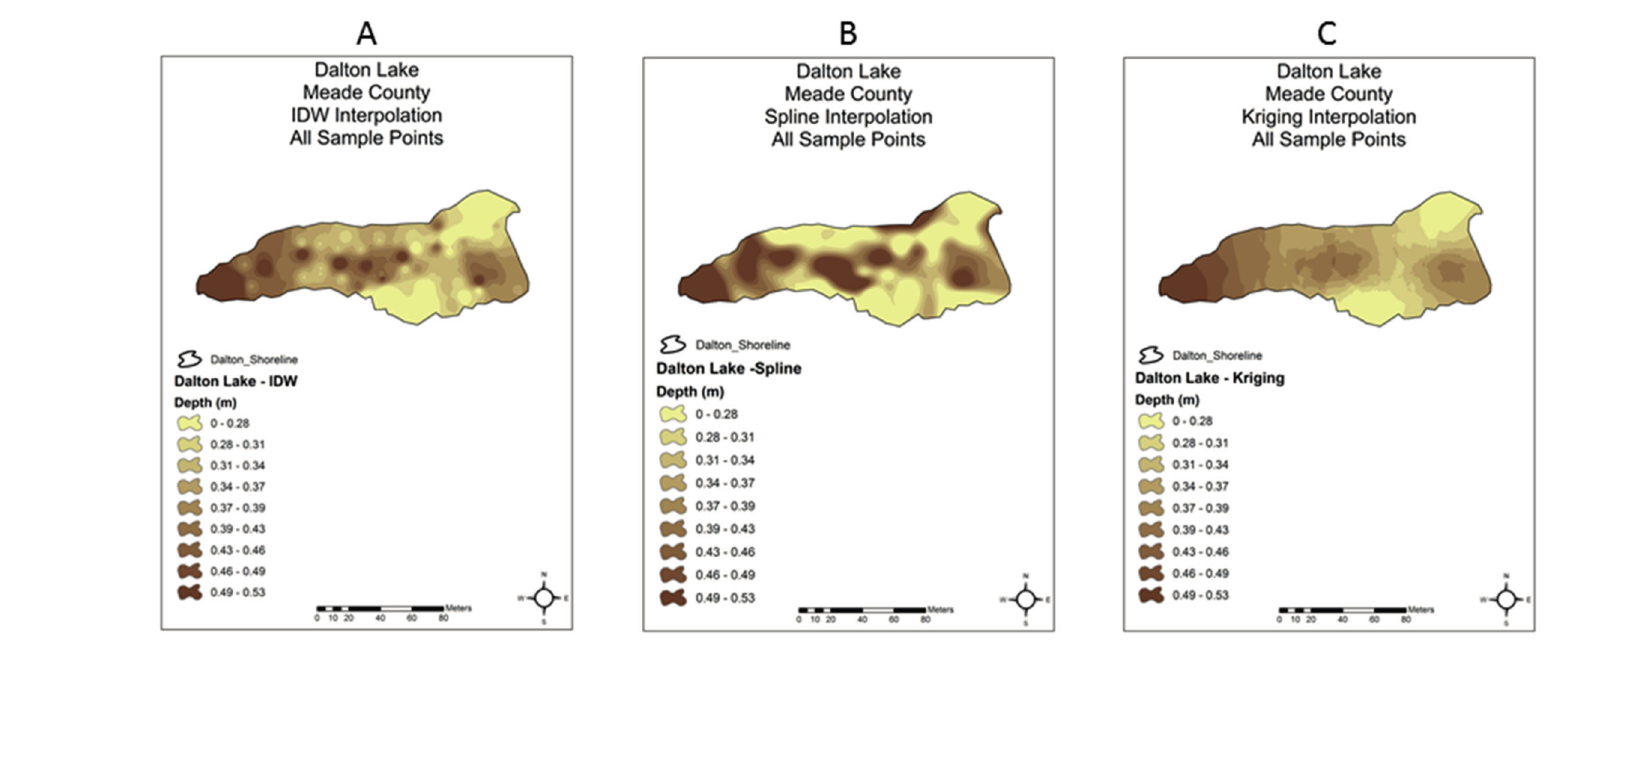
Figure 4. Sediment maps of Dalton Lake within the Black Hills of South Dakota using IDW interpolation to depict extent and distribution of sediment within the lake. Inverse Distance Weighted is identified with the subset letter ( A ), Spline is identified with the subset letter ( B ) and kriging is identified with the subset letter ( C